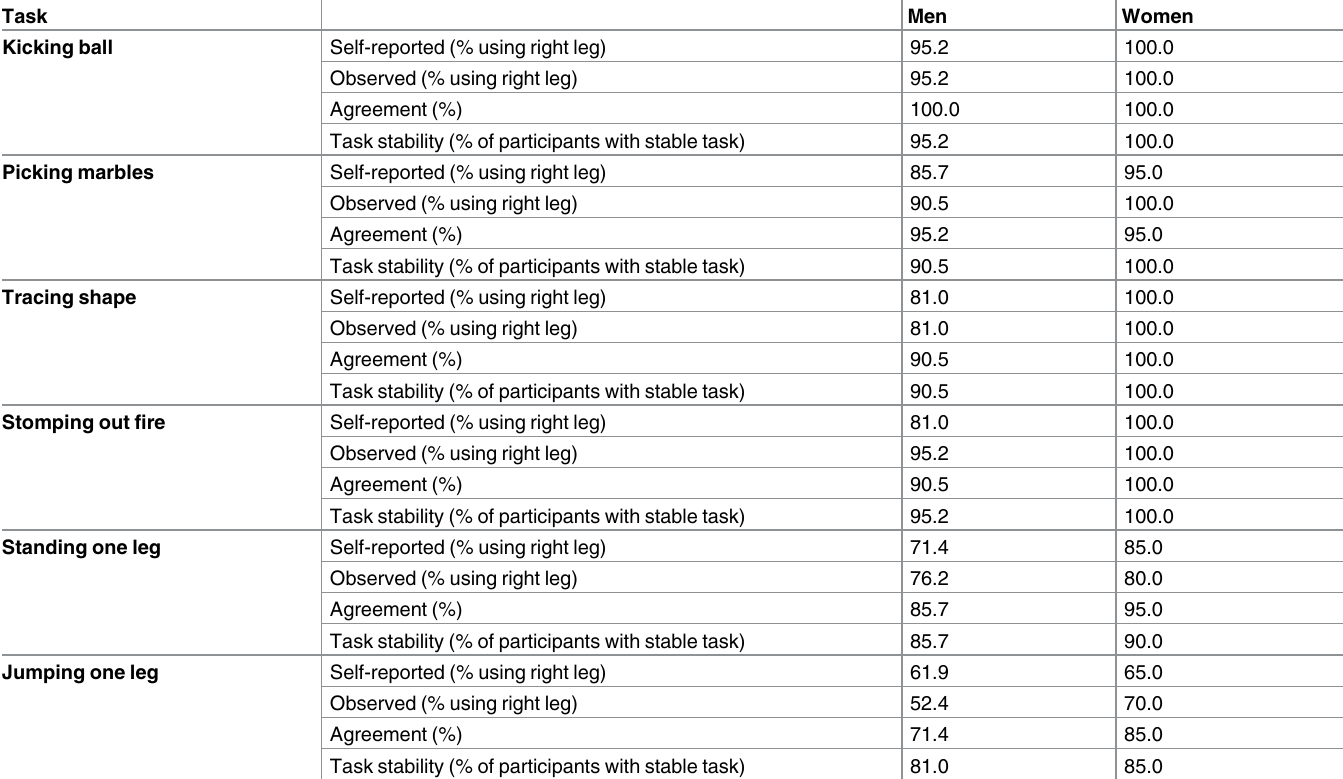
Table 1. Percentages of agreementbetween self-reported and observed leg dominance and task stability for the four bilateral mobilizing tasks and two unilateral stabilizing tasks. Task Kicking ball